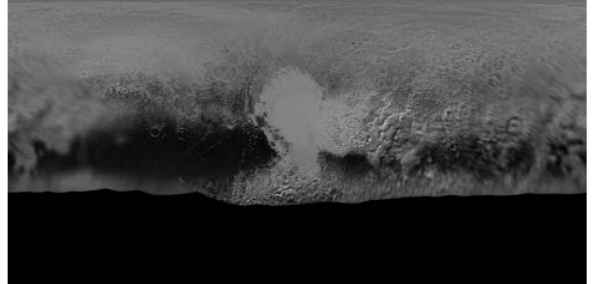
sphere. Parallax in the approach images was simply insufficient to resolve topography on these bodies at these distances. Shape-from-shading compliments the stereo with pixel-scale slope measurement over areas of low-Sun.